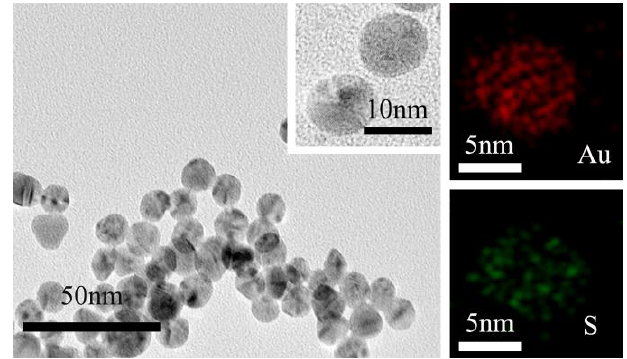
Figure 2. TEM images and energy dispersive spectrometry (EDS) element mappings of the β- CD@AuNPs; the red and green colors correspond to elemental Au and S, respectively.